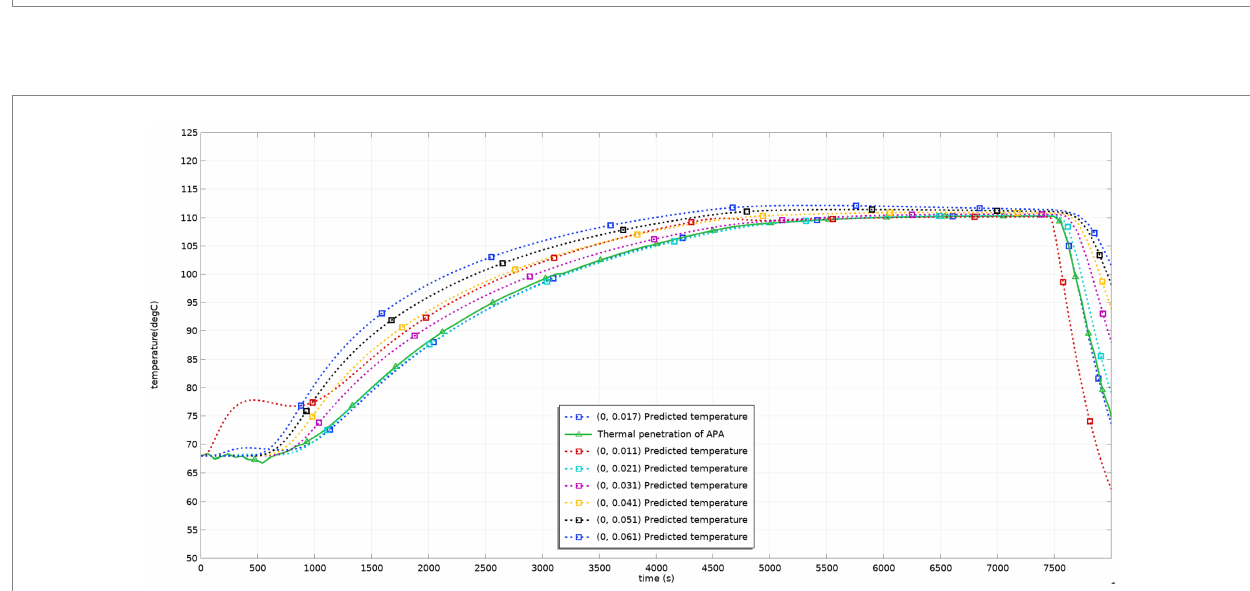
FIGURE. 8 Predicted and tested values of the temperature at the SHZ after process adjustments.